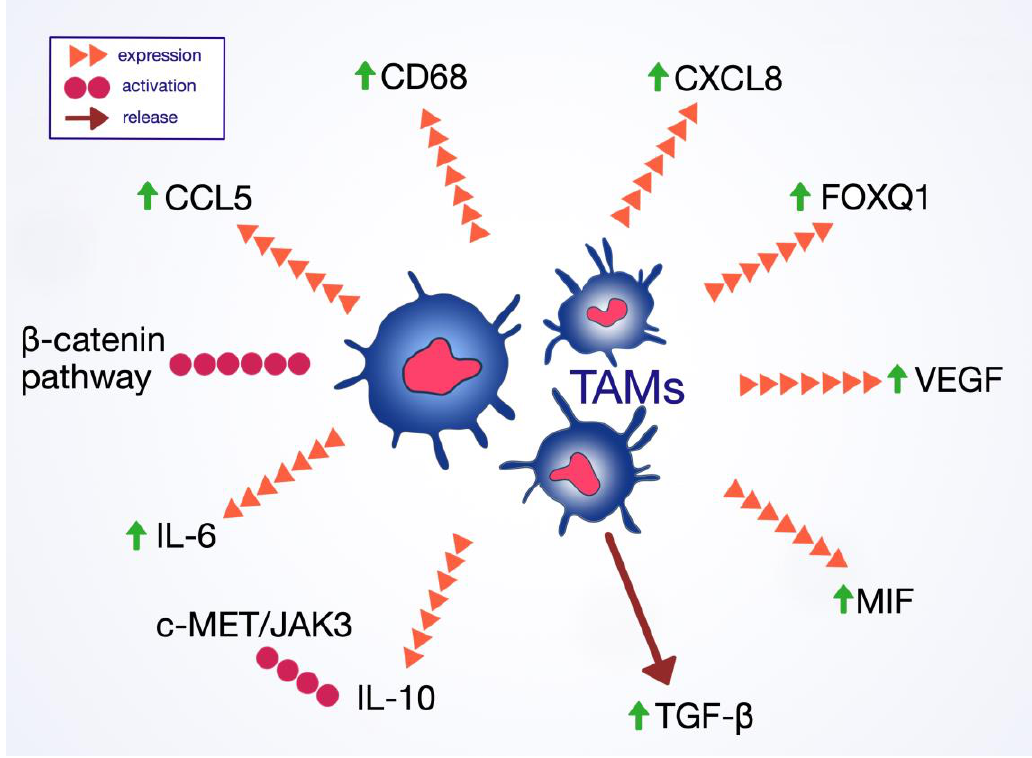
Figure 3. Involvement of tumor-associated macrophages in EMT and gastric cancer progression.